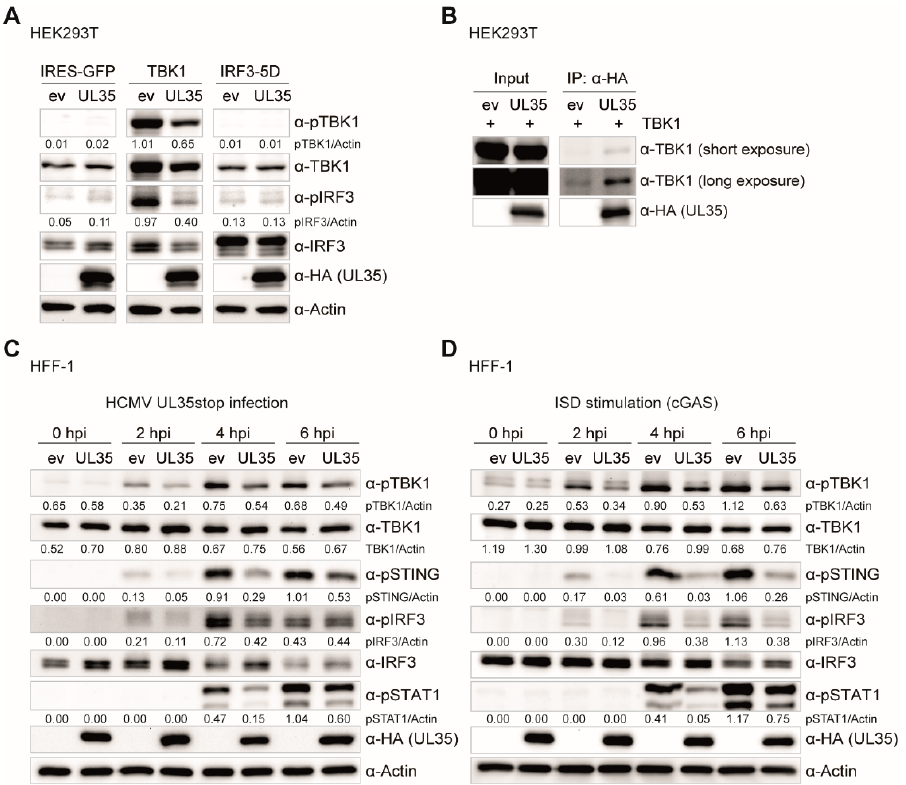
Figure 7. UL35 interacts with TBK1 and impairs the phosphorylation events within the TBK1-STING- IRF3 axis. ( A ) HEK293T cells were co-transfected with IRES-GFP (unstimulated), TBK1, or IRF3-5D together with either empty vector (ev) or UL35-HA. 20 h later, cells were lysed and whole cell lysates analyzed by immunoblotting for phosphorylated TBK1 (pTBK1), total TBK1, phosphorylated IRF3 (pIRF3), total IRF3, anti-HA for UL35, and Actin. ( B ) HEK293T cells were transfected with TBK1 together with either ev or UL35-HA. 20 h later, cells were lysed and 10% of the whole cell lysate was used for the input control. The remainder was subjected to immunoprecipitation with an anti-HA antibody to precipitate UL35. Input and IP fractions were analyzed by immunoblotting with anti-TBK1 and anti-HA antibodies. ( C ) HFF-1 stably expressing ev or UL35-HA were infected with HCMV UL35stop at an MOI of 0.1. Cells were lysed 0, 2, 4 and 6 h later and analyzed by immunoblotting with anti-pTBK1, anti-TBK1, anti-pSTING, anti-pIRF3, anti-IRF3, anti-pSTAT1, anti-HA, and anti-Actin antibodies. ( D ) HFF-1 stably expressing ev or UL35-HA were stimulated by transfection of ISD and immunoblotting was performed as described in ( C ). ( A-D ) One representative experiment out of two independent experiments is shown. Quantification of band intensities relative to the corresponding Actin band was performed using ImageJ and is shown below the corresponding immunoblot.